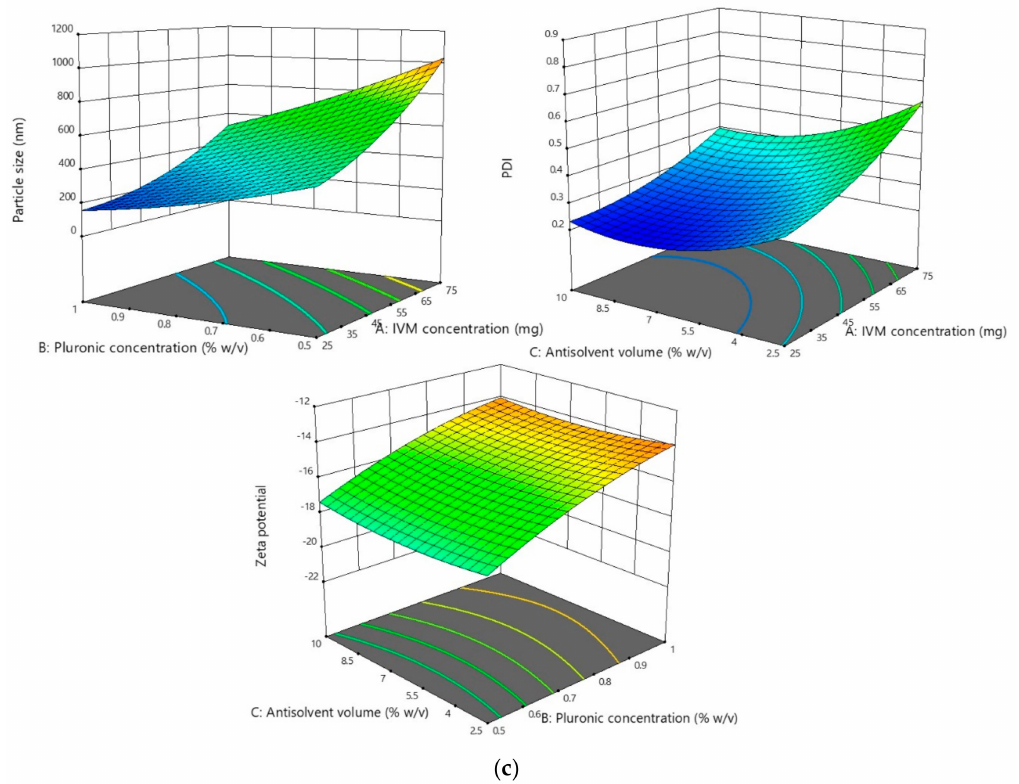
Figure 2. ( a ) Representative response surface plots describing the e ff ect of dependent variables on the particle size, polydispersity indexes (PDI), and zeta potential of doxycycline (DOX) NS. ( b ) Representative response surface plots describing the e ff ect of dependent variables on the particle size, PDI, and zeta potential of albendazole sulfoxide (ABZ-OX) NS. ( c ) Representative response surface plots describing the e ff ect of dependent variables on the particle size, PDI, and zeta potential of ivermectin (IVM)